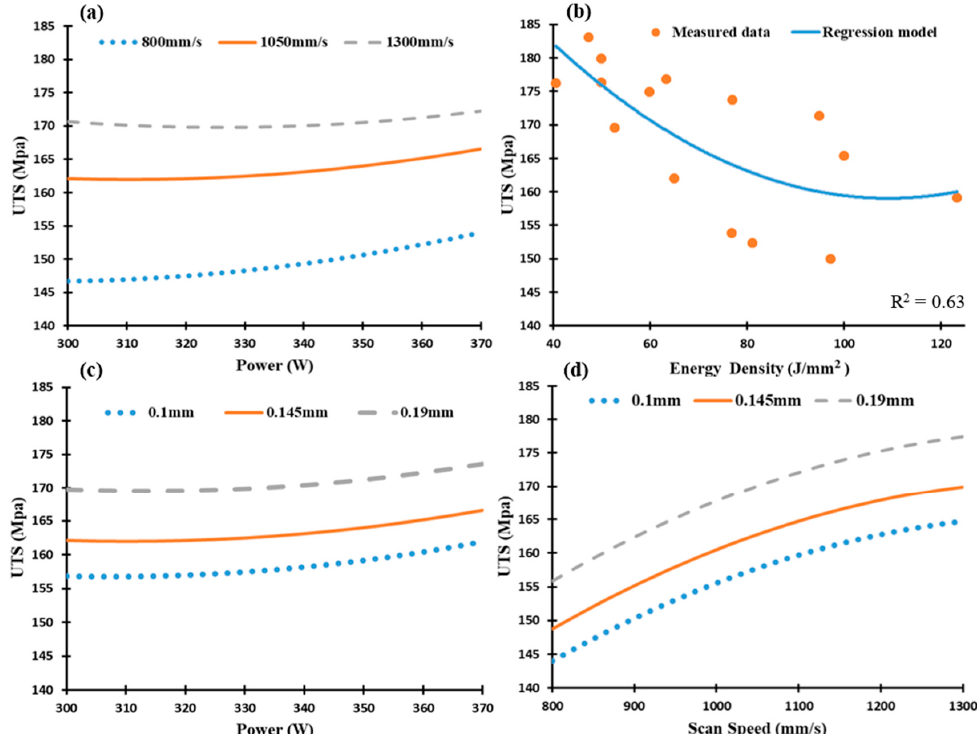
Figure 16. Ultimate tensile strength of the as-built Al6061 samples along the building direction vs. ( a ) Laser power (W); ( b ) Energy density (J/mm 3 ), ( c ) Hatch Spacing (mm), and ( d ) Scan speed (mm/s).